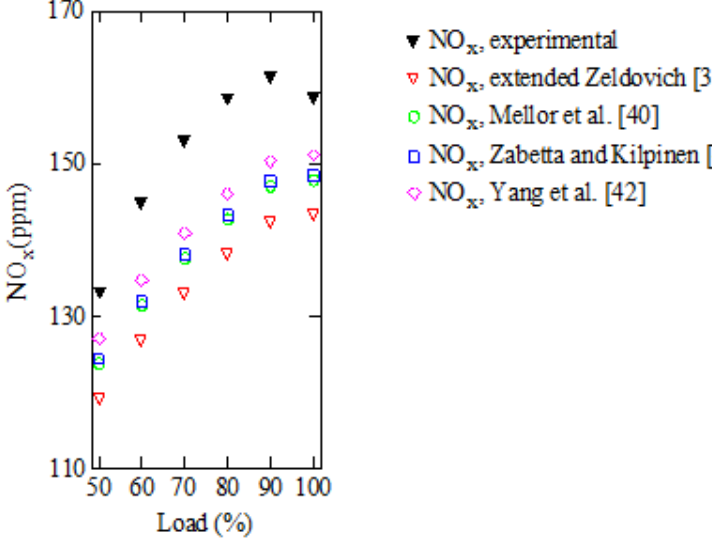
Figure 4. NO x emissions experimentally and numerically obtained.